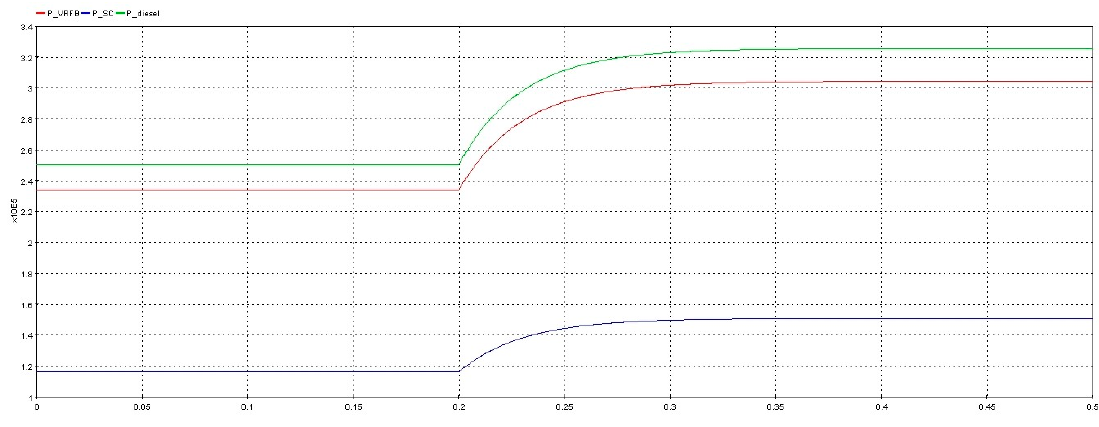
Figure 17. Power regulation curves using traditional droop control.